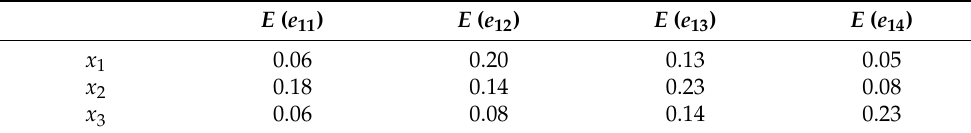
Table 2. Entropy of each parameter of hydrological and climatic conditions B 1 at time t 2 .